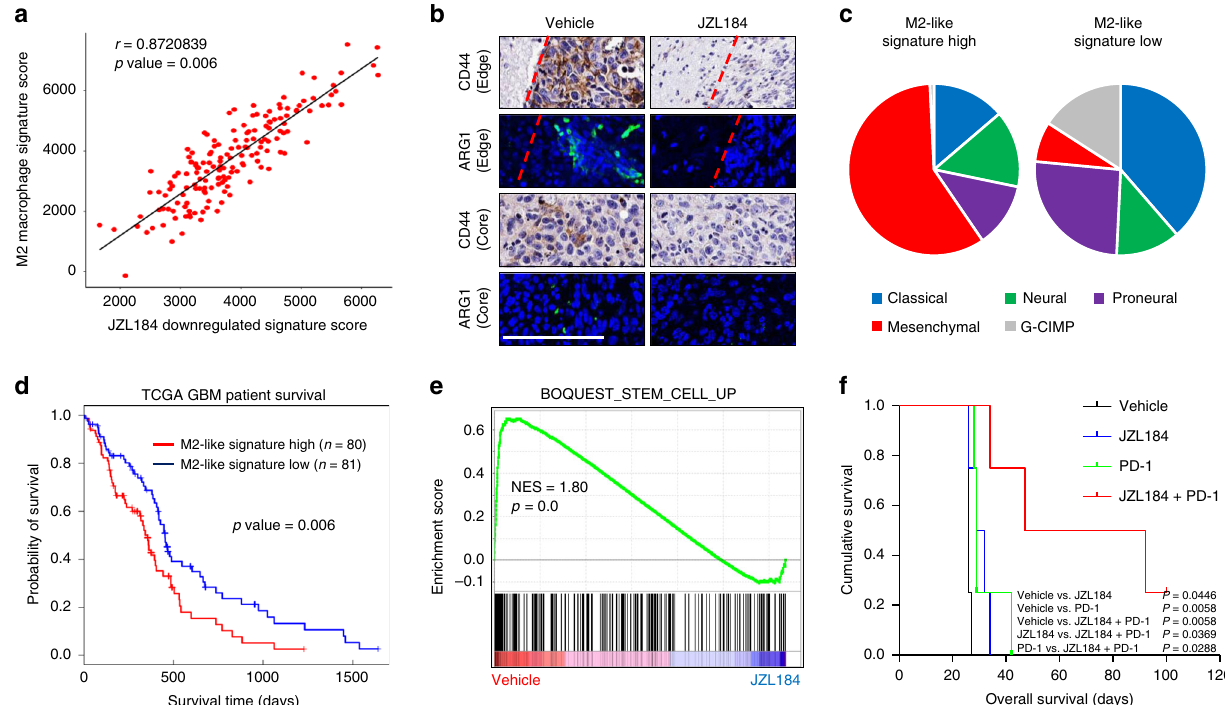
Fig. 8 JZL184 inhibits M2-like TAMs signature and associated with patients survival. a Correlation dot-plot of JZL184 downregulated gene signature and M2 gene signature of TAMs from vehicle vs. JZL184-treated subcutaneous mouse model. b Representative IHC and IF images of CD44 and ARG1 in edge or core tumor regions of brain slices treated with JZL184 or vehicle. Scale bar, 100 µ m. c Pie chart of ratio of GBM subtypes according to high and low expression of M2-like gene signature. d Kaplan – Meier survival plots for GBM patients in the TCGA data set according to high (top 50%) and low (bottom 50%) M2-like signature expression. e Gene Set Enrichment Analysis (GSEA) plot for stemness gene signature in comparison of TAMs from vehicle vs. JZL184-treated subcutaneous mouse model. f Kaplan – Meier survival plots for the orthotopic syngeneic mouse model ( n = 4). Median survival of the orthotopic syngeneic mice treated with Vehicle, PD-1, JZL184, or PD-1 + JZL184 was 26 days, 29 days, 30.5 days, and 69.5 days,